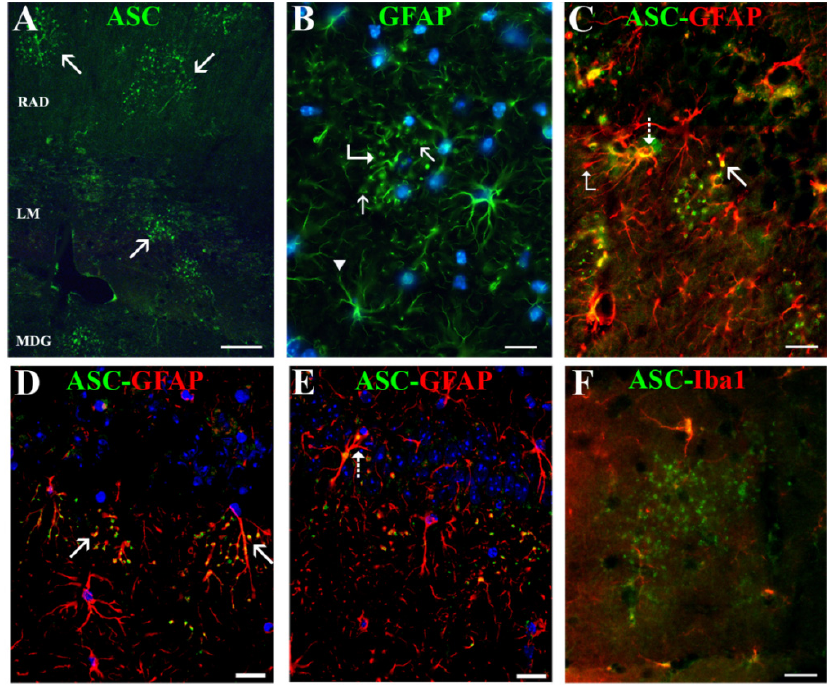
Figure 4. APP frequently show foci of ASC granules dispersed throughout the HP, intimately associated withspecific astrocytes, which also contain ASC in their cytoplasm. ( D , E ) are confocal images of a same z-stack. ( A ) shows a panoramic view of three distinct strata in the HP of an APP/D, i.e., strata radiatum (RAD), lacunosum- molecularis (LM), and molecularis of DG (MDG), which present distinct foci of ASC granules (arrows). ( B , C ) reveal the appearance of specific GFAP-positive astrocytes (bent arrow in ( B )) associated with these ASC granules (arrows in ( C , D )), which have swellings along their processes (bent arrow in ( C )) and terminate in loops (arrows in ( B )) instead of the more common tapered terminals (arrowhead in ( B )). The intimate association of these granules with astrocytic processes is seen in ( D ) (arrows) and ( E ), and the presence of ASC next to the nucleus and in primary processes is seen in ( C ) and ( E ) (dashed arrows). ( F ) shows no apparent association between ASC granule clusters and Iba1-positive microglia. Scale bars represent 50 µm in ( A ), and 20 µm in ( B – F ).